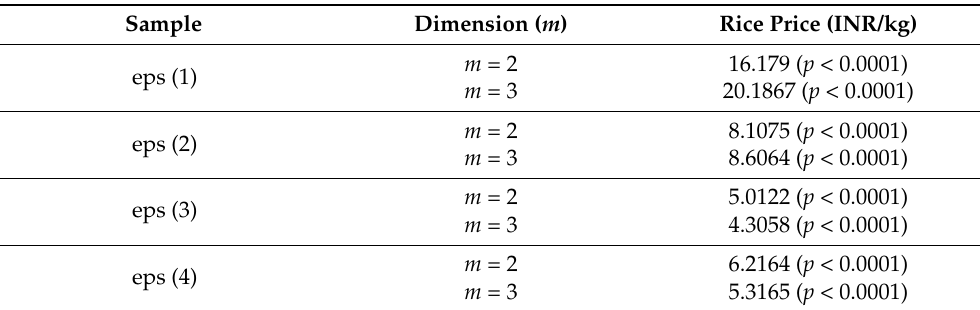
Figure 1. Time series plot of all India rice prices. Table 2. BDS test for nonlinearity (eps—values of epsilon or standard deviation of sample input variable; m —embedded dimension; p